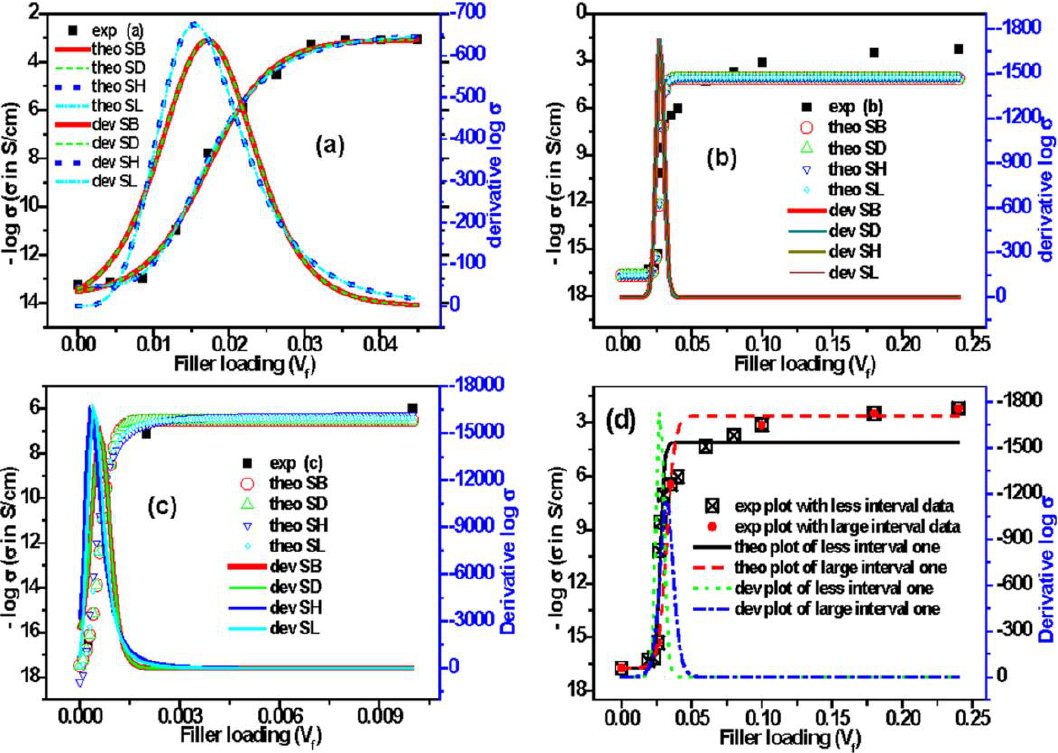
Figure 10. Experimental, different Sigmoidal and derivative curves: ( a ) Reference [44]; ( b ) Reference [45]; ( c ) Reference [46]; and ( d ) plots of Reference [45] based on less and large interval data points.